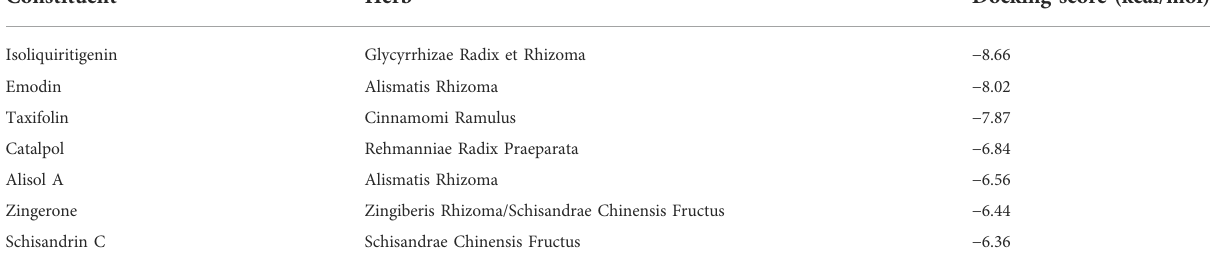
TABLE 1 Information of the seven potential active constituents.